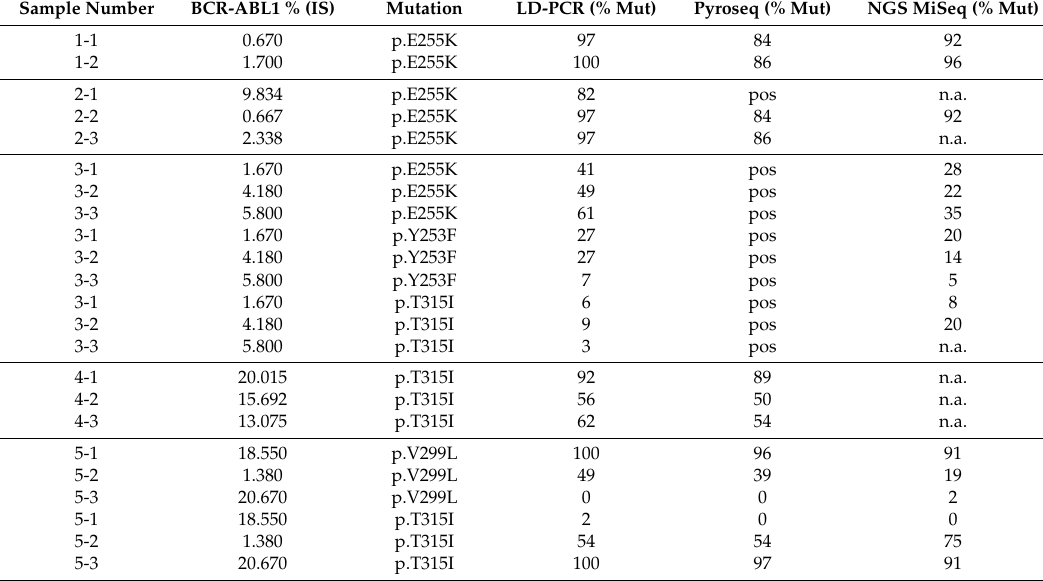
Table 1. Single and serial peripheral blood specimens from 19 CML patients displaying up to three different mutant subclones were subjected to quantitative analysis by LD-PCR, pyrosequencing and/or NGS on the MiSeq platform (Illumina). Serially derived specimens from individual patients are indicated by increasing numbers after the hyphen. The BCR-ABL1 transcript levels in individual specimens are indicated according to the International Scale (IS). The sizes of mutant subclones determined by the technical approaches tested are displayed as a percentage of the BCR-ABL1 positive cells. n.a., not analyzed; n.d., not detected; pos, detected but not